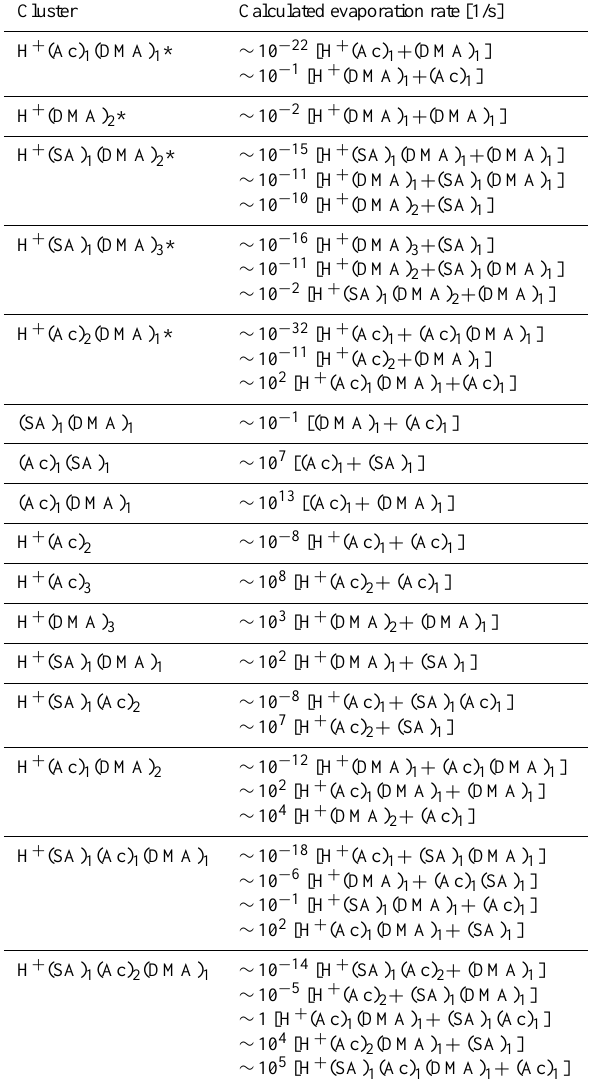
Table 2. The order of magnitudes of evaporation rates for the possi- ble evaporation reactions for each cluster type that is formed in the simulation and is within the size limits presented in Table 1. The cluster types listed in Fig. 5 are marked with an asterisk (*).